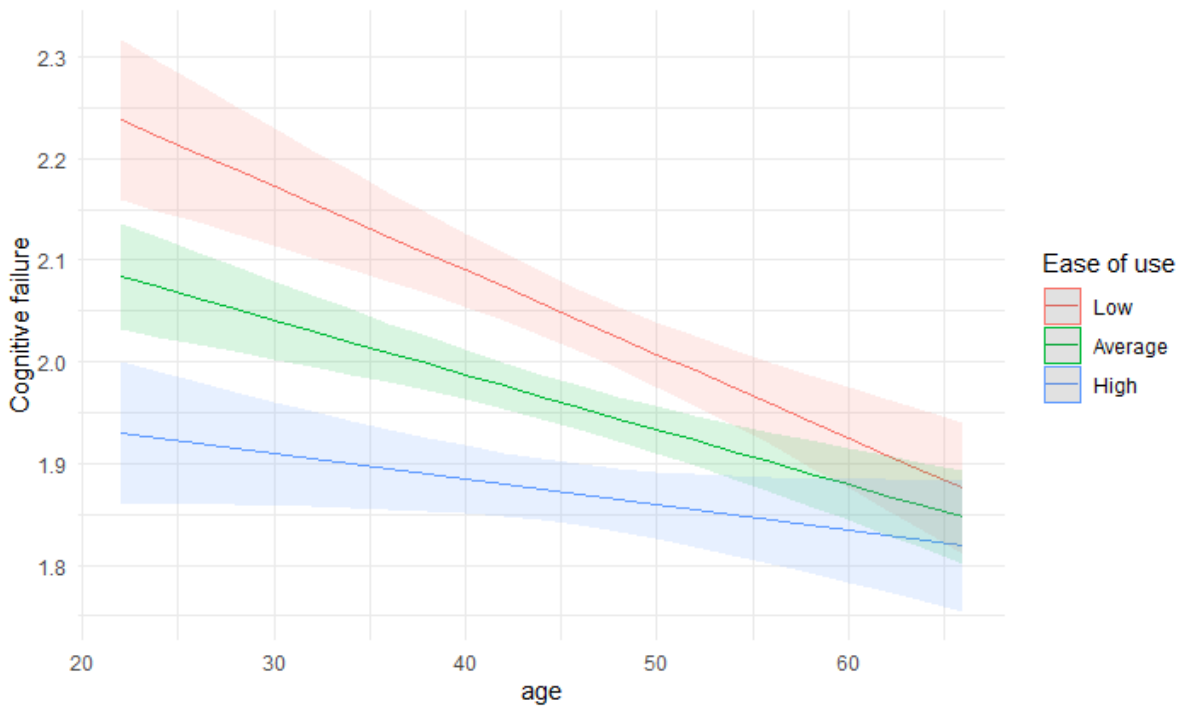
Figure 1. Interaction effect between EHR usability (ease of use) and user’s age for cognitive failures. The association is shown for low (mean − 1 SD), average, and high (mean + 1 SD) levels of ease of use. EHR: electronic health record.